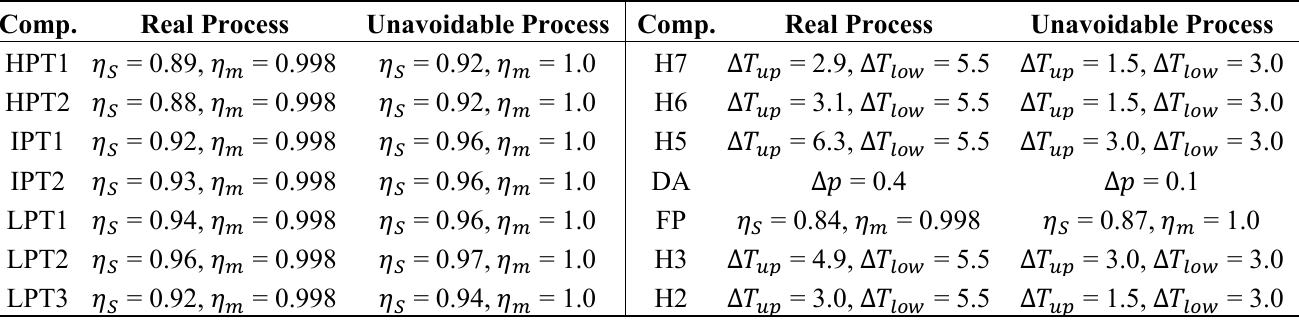
Table 3. Assumptions of theoretical and unavoidable conditions